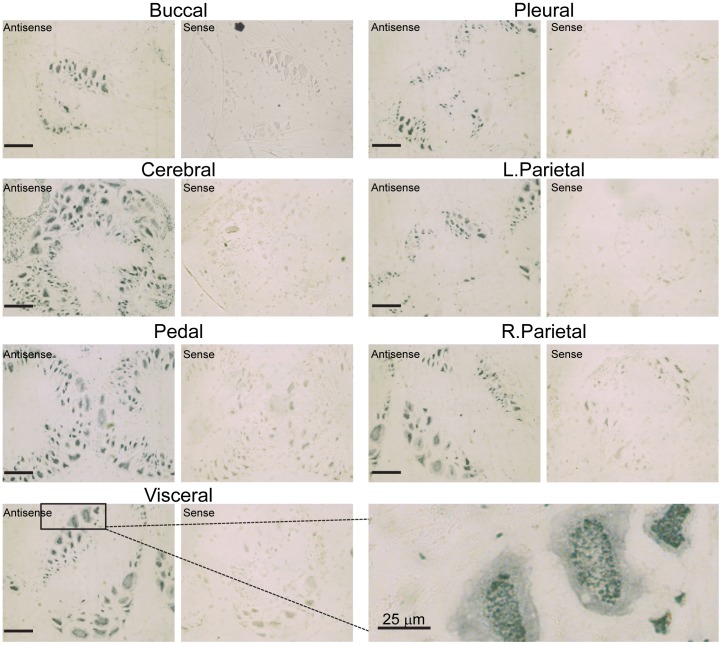

In situ hybridization.Wax embedded sections of Lymnaea CNS were probed with Digoxigenin labelled LymP2X sense and antisense cRNA probes. Representative images of each ganglia are shown. Scale bars = 100 µm unless indicated otherwise. Bottom right hand panel shows a higher magnification image (scale bar = 25 µm) of neurones in the visceral ganglia, emphasising the diffuse cytoplasmic and punctate nuclear staining observed with the antisense LymP2X probe.